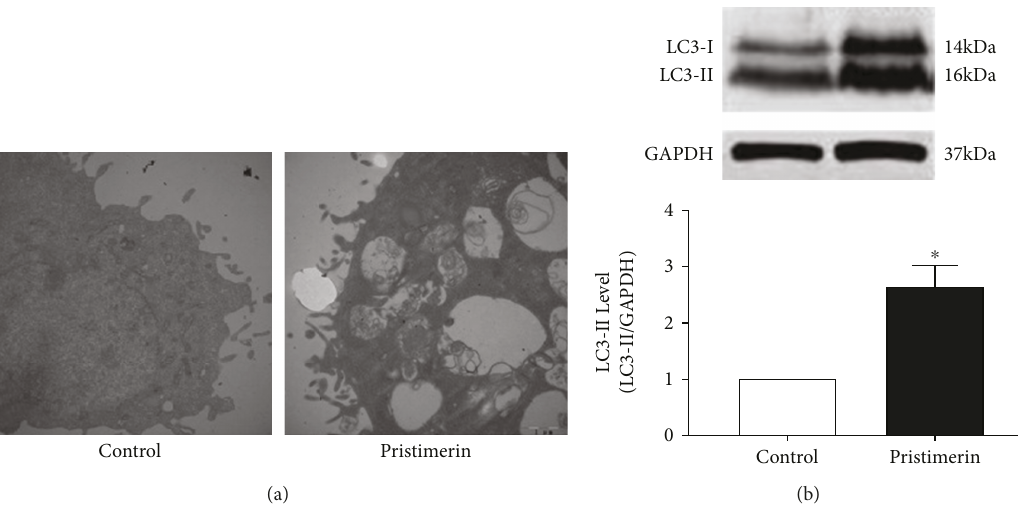
Figure 3: Pristimerin induces expression of autophagy-related protein in Eca109 cells: (a) EM staining of pristimerin-induced autophagy and (b) the protein level of LC3-I/LC3-II. Data are expressed as mean ± SEM ; n = 3 for each group. ∗ P < 0 05 versus control